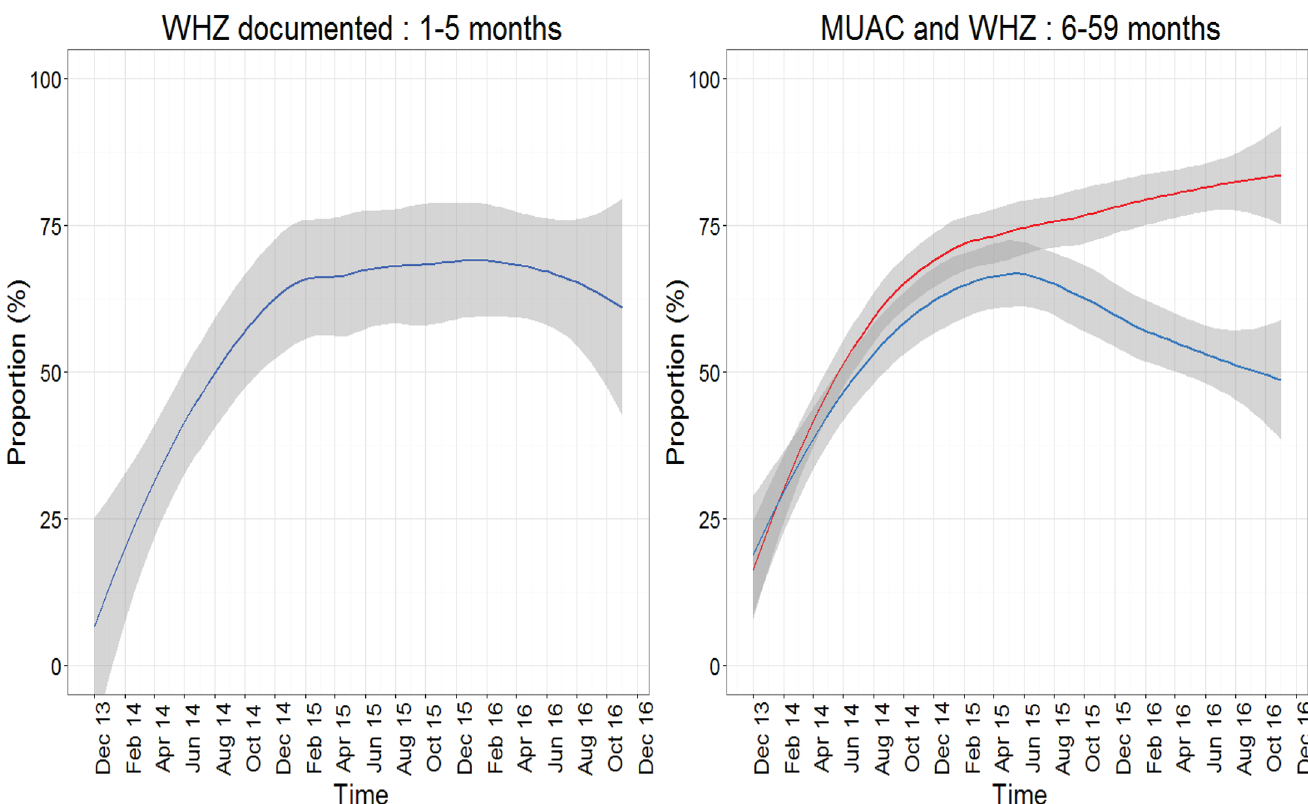
Fig 2. Documentation of WHZ score among all children 1 to 5 months (panel a) and WHZ score and MUAC documentation among all subgroups of SAM aged 6 to 59 months in 13 CIN hospitals over time (panel b): WHZ (blue line) and MUAC (red line).